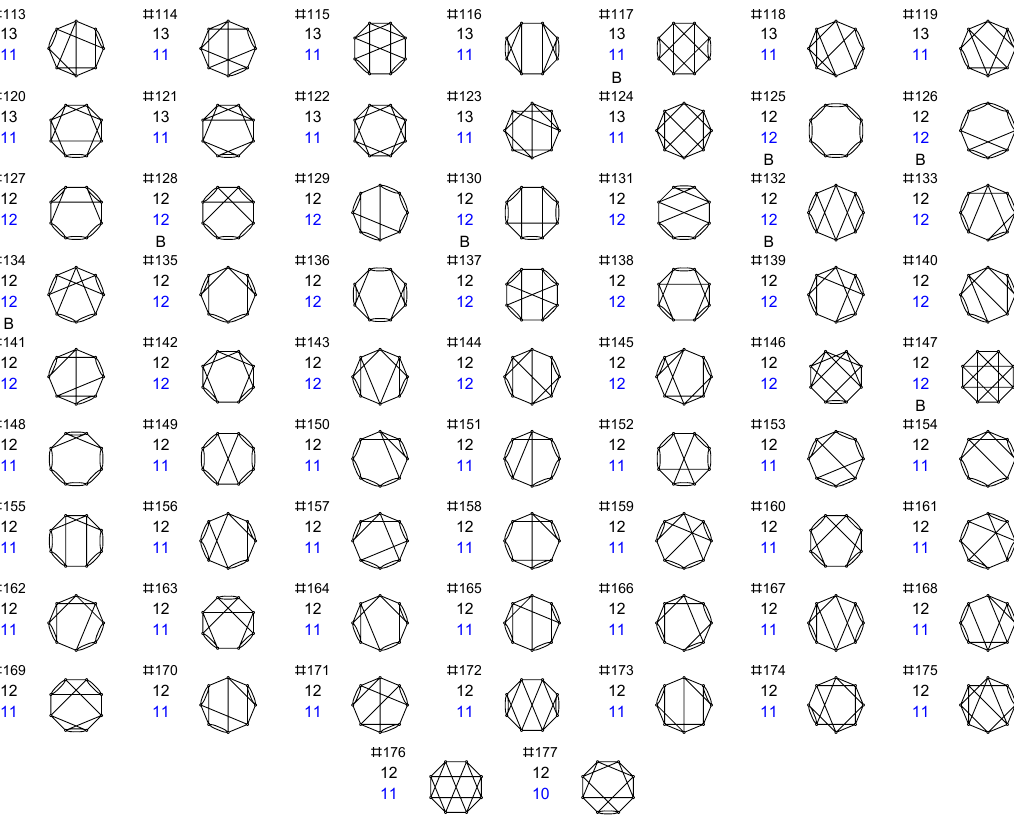
Figure 8 . (Part 2 of 2) All vacuum diagrams of order g 8